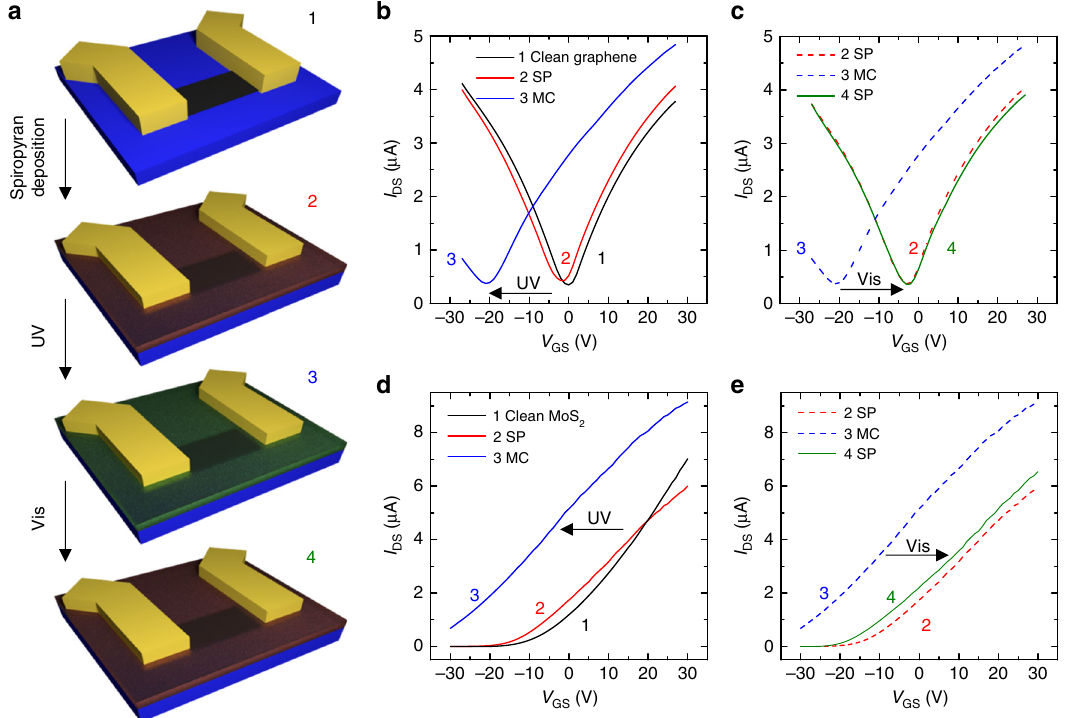
Fig. 3 Electrical characteristics of devices based on photo-switchable superlattices. Transfer characteristics ( I DS – V GS ) of devices based on graphene and MoS 2 superlattices. I DS is the drain current, and V GS is the gate potential. a Schematics of the experiment. I DS – V GS characteristics are measured on: (1) A 2DM-based clean device; (2) after spin-coating of the spiro fi lm; (3) after irradiation with a UV light over the whole fl ake, which triggers the SP → MC isomerization; (4) after green light irradiation over the whole fl ake, which triggers the MC → SP isomerization. Gold contacts are schematically drawn in yellow, the 2DM in dark gray; the substrate in blue; the SP layer in semi-transparent red; the MC layer in semi-transparent green. b Trace 1 (black): clean graphene, trace 2 (red): graphene covered by the SP layer, trace 3 (blue): graphene/MC after UV irradiation over the whole fl ake. The arrow highlights the negative shift in the threshold voltage accompanying the SP → MC isomerization, indicative of n -type doping. c Trace 4 (green): recovered graphene/SP after green light irradiation of the whole graphene surface. Traces 2 and 3 are replotted for clarity (dashed). d Trace 1 (black): clean MoS 2 , trace 2 (red): MoS 2 covered by the SP layer, trace 3 (blue): MoS 2 /MC after UV irradiation over the whole fl ake. e Trace 4 (green): the pristine MoS 2 /SP trace can be recovered upon irradiation of the whole surface with green light. Traces 2 and 3 are replotted for clarity. Details about the UV and green light irradiation are given in the Methods section; the transfer curves were measured applying a drain source voltage V DS = 10 mV for graphene ( b , c ) and V DS = 100 mV for MoS 2 ( d , e ). Channel length L = 8.9 µ m and width W = 1.0 µ m (graphene); L = 1.8 µ m, W = 3.3 µ m (MoS 2